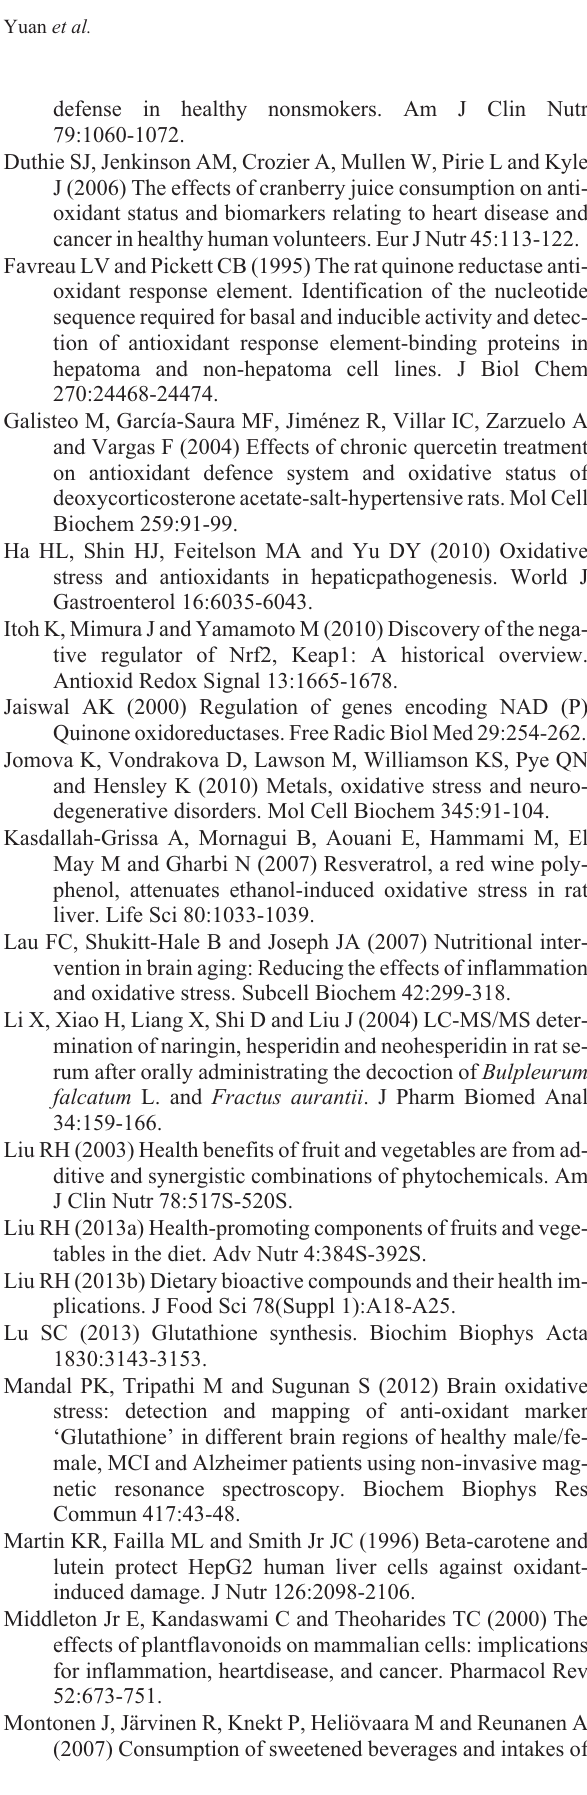
vegetable (FV) juice dietary intervention for 5